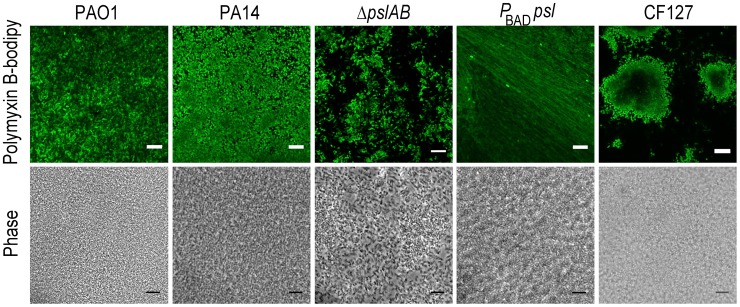
Polymyxin B interacts with the Psl extracellular matrix.Images of WT PAO1, PA14, ΔpslAB, PBAD-
psl, and CF127 biofilms subjected to 5 µg/ml fluorescent polymyxin B after 2 hours of exposure. Polymyxin B accumulates in the extracellular material of P
BAD-
psl and is less pronounced in WT PAO1 biofilms. Fluorescent Polymyxin B did not localize to the matrix in PA14 or ΔpslAB biofilms, but instead closely associated with the cell surface. For CF127, Polymyxin B was distributed around the periphery of microcolonies within the biofilm. Scale bars represent 10 µm.